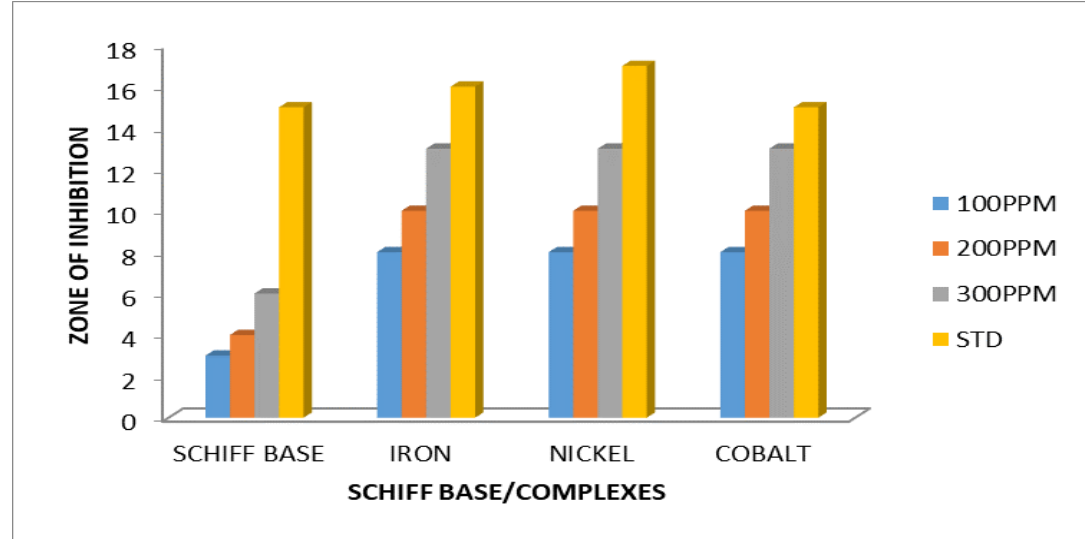
Figure 5. Sensitivity test for antifungal activity of Schiff base and its metal (II) complexes against clinical isolate ( Aspergillus niger ) using well diffusion method.